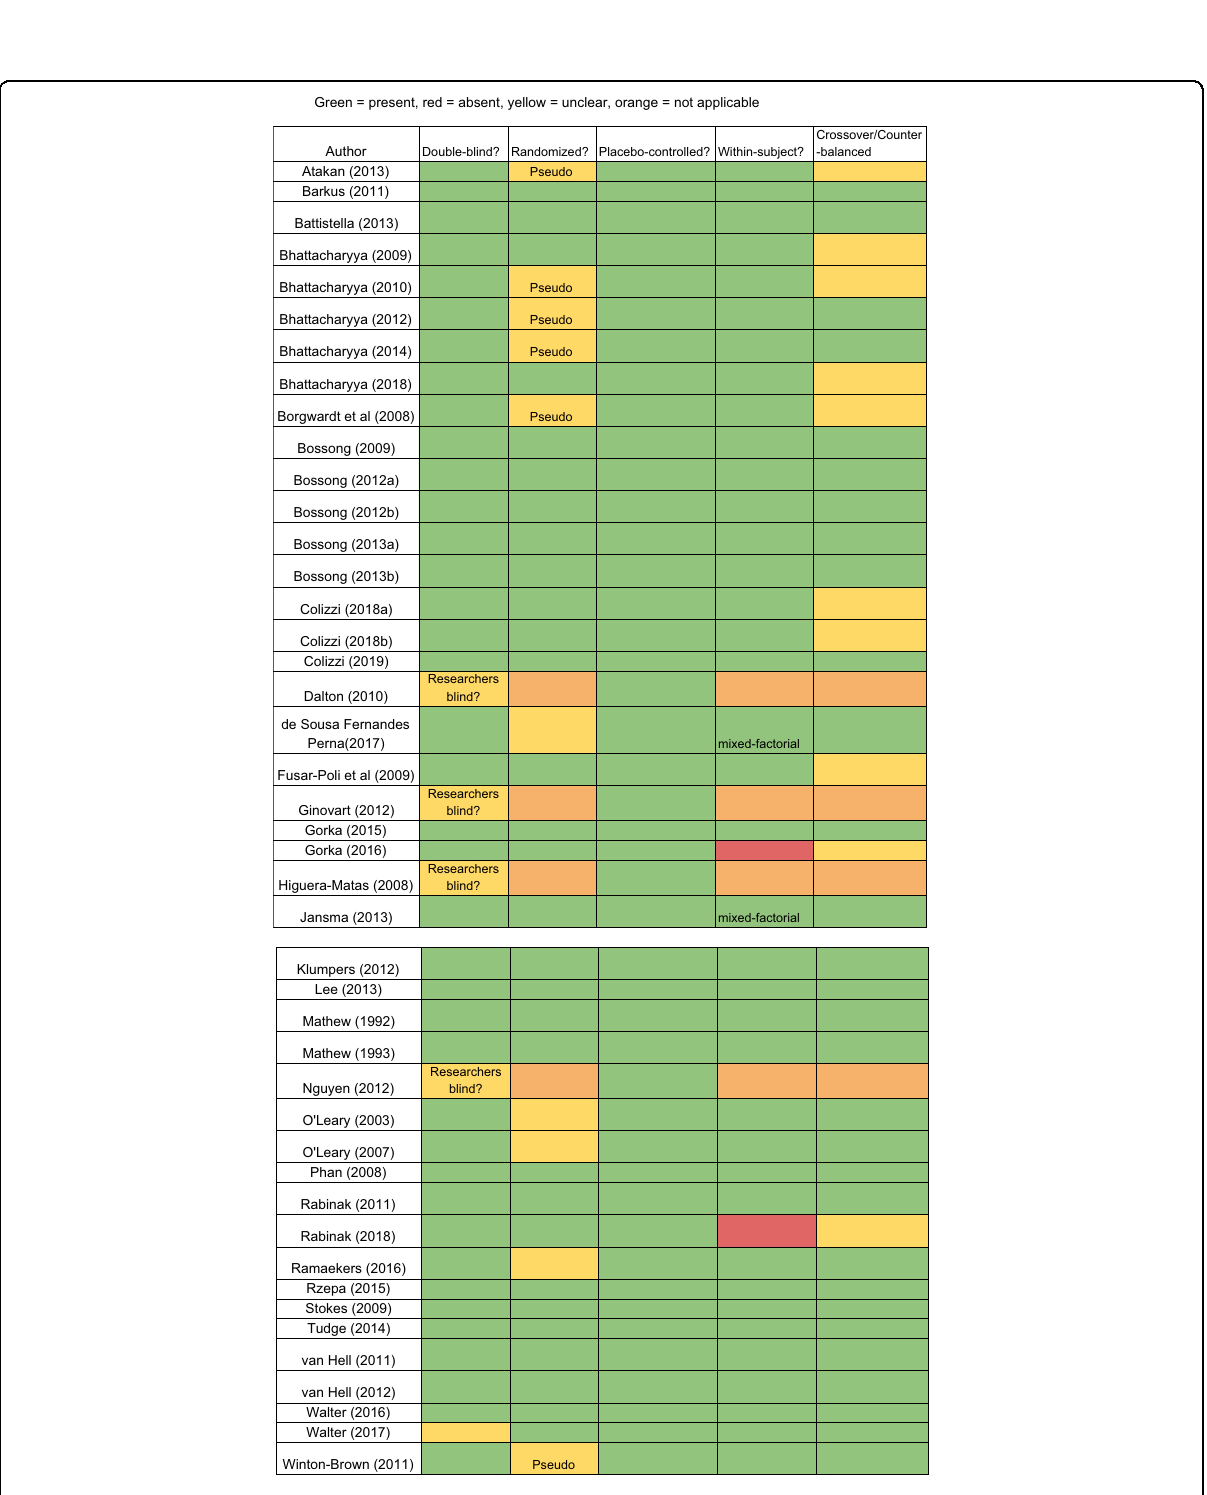
Emotional processing in psychosis . Participants at risk for psychosis demonstrated altered activation in response to valenced faces when compared to control groups 75 .